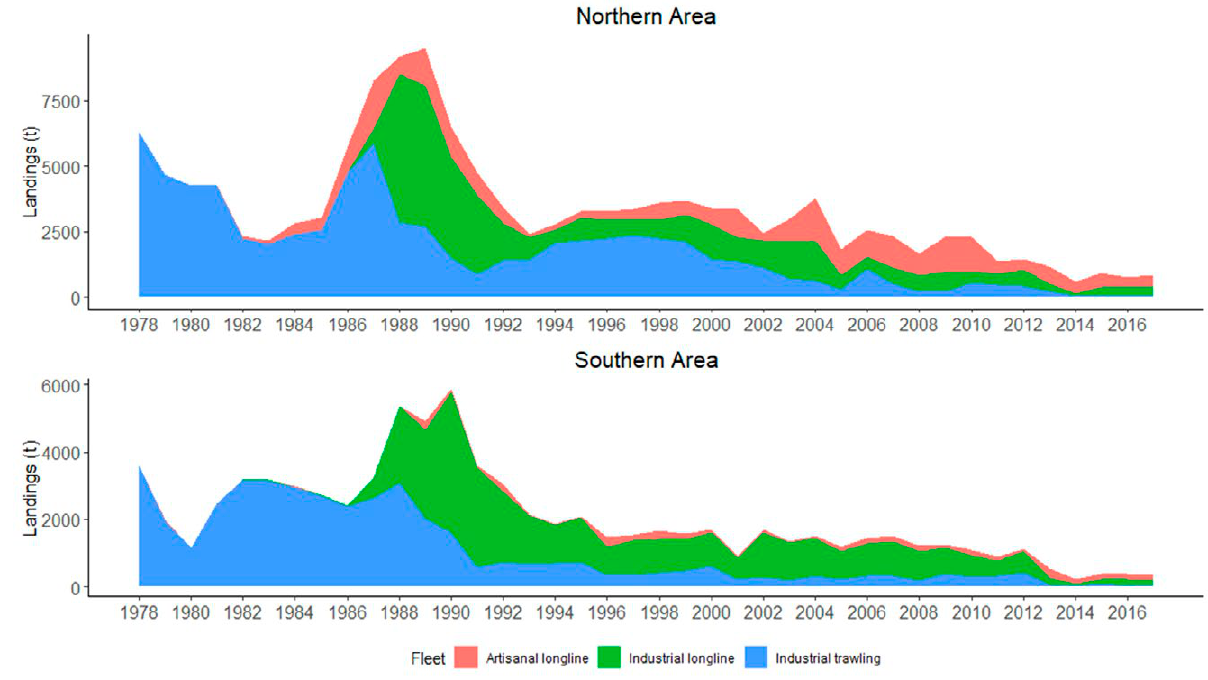
Fig. 2. – Stacked plots of historical landing in pink cusk-eel by fleets and fishing